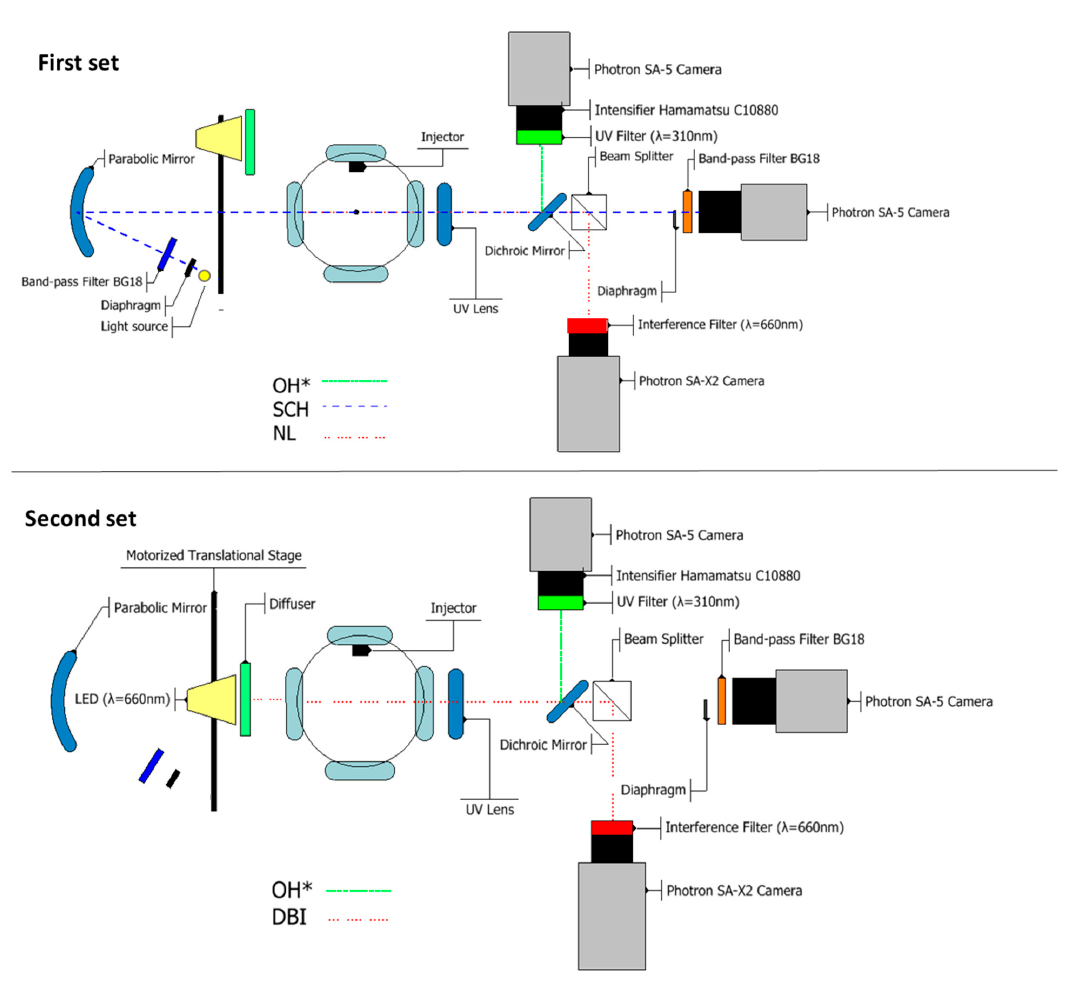
Figure 1. Optical arrangement for the first set up ( top ) and second setup ( bottom ).